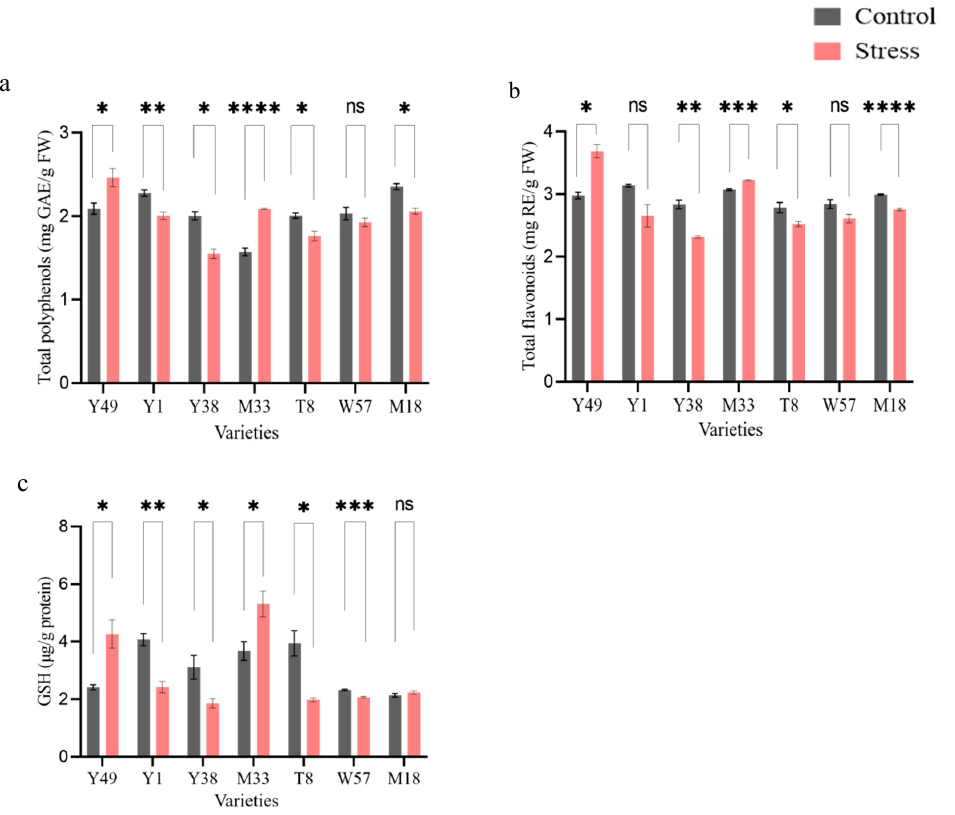
Figure 4. Influence of cold stress on enzymatic and non-enzymatic antioxidants in jute varieties. Plants under control (28 °C) and stress (5 °C) showed a response in: ( a ) Total polyphenol, ( b ) Total flavonoid, and ( c ) GSH activity. Different significant level marked with **** p < 0.0001, *** p ≤ 0.001, ** p ≤ 0.01, * p ≤ 0.05, and ns mean